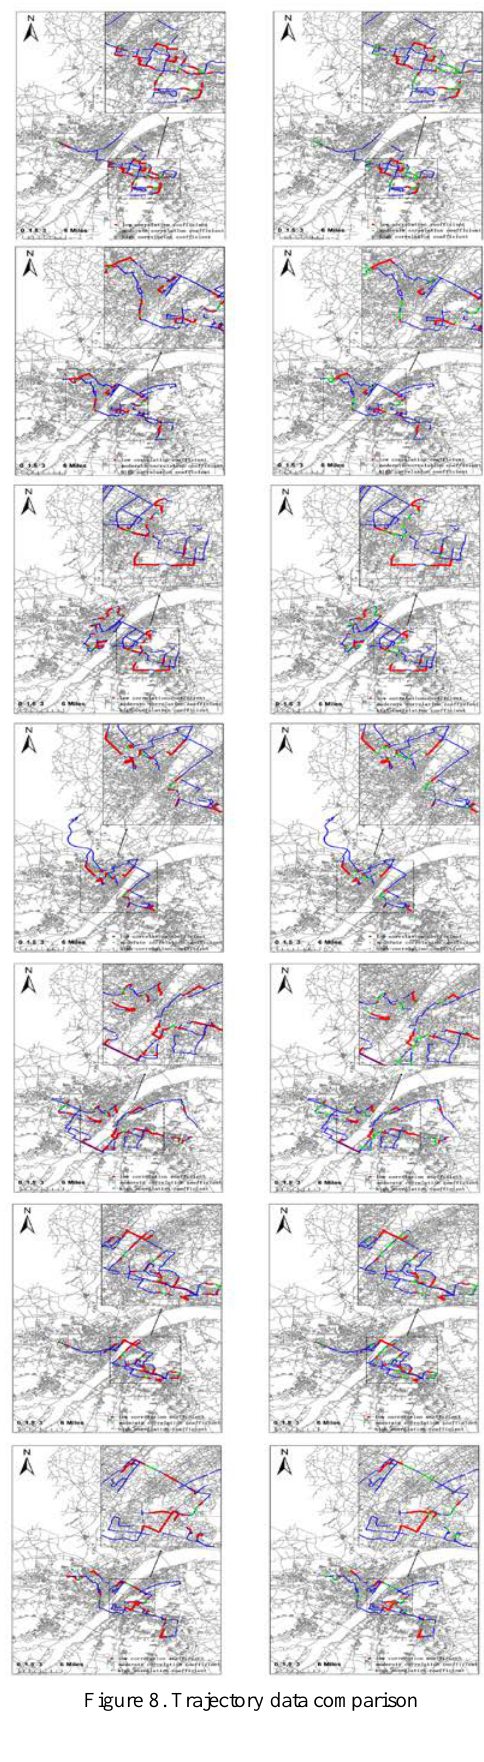
Figure 8. Trajectory data